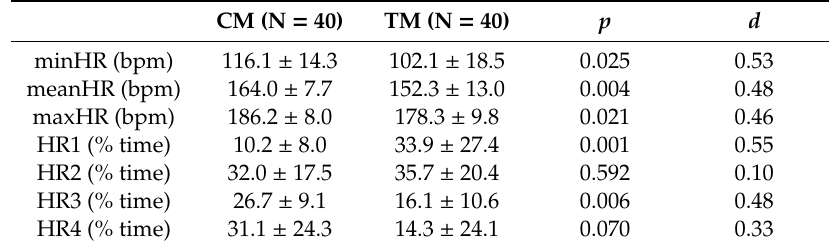
Table 1. Paired tests of physiological responses of soccer players in competition matches (CM) and training matches (TM).